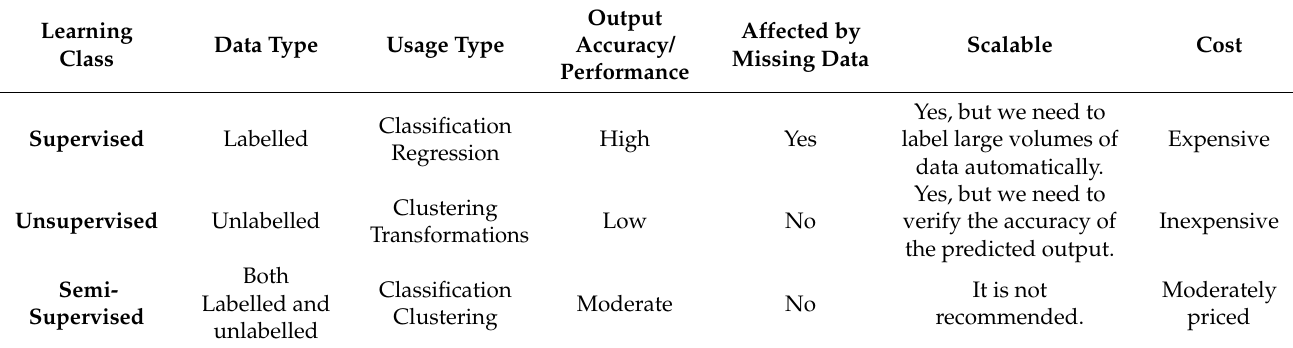
Table 2. The difference between supervised learning, unsupervised learning, and semisupervised